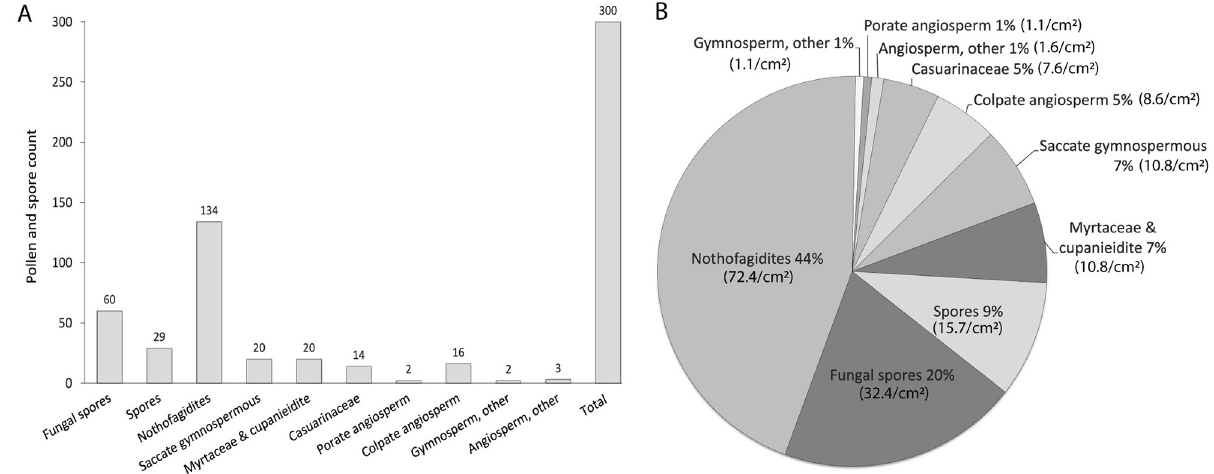
Fig 5. Microfossil identification, counts, and abundance. ( a ) The total number of palynomorphs identified across 1.85cm 2 of rock surface analysed. Note ‘Spores’ indicates that from ferns and mosses. ( b ) Pie chart showing the relative abundance (%) of palynomorphs, and in brackets, palynomorph density (number of specimens/cm 2